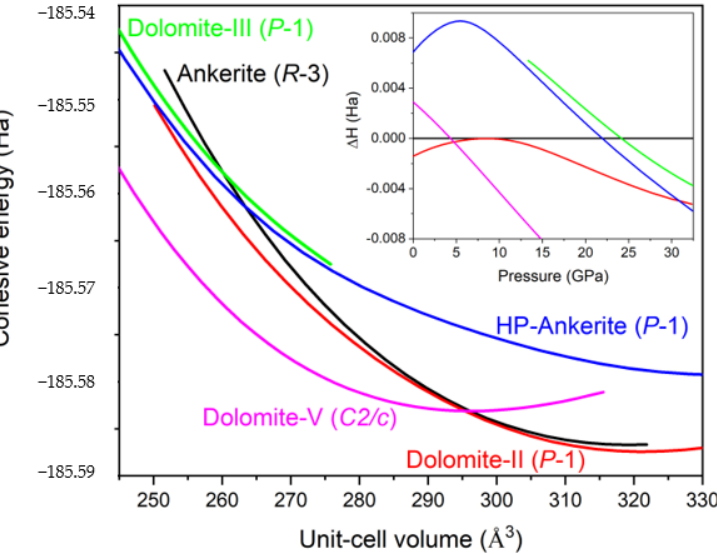
Figure 7. Cohesive energy as a function of the volume per CaFe(CO 3 ) 2 formula unit for the R - 3 ̅ dolomite-I-type, P - 1 ̅ dolomite-II-type [19], P - 1 ̅ dolomite-III-type [19], C 2/ c dolomite-V-type [12], and the P - 1 ̅ “HP-ankerite” (this work) ankerite phases. Inset: Enthalpy difference as a function of pressure, showing the stabilities with respect to R - 3 ̅ CaFe(CO 3 ) 2 ankerite.